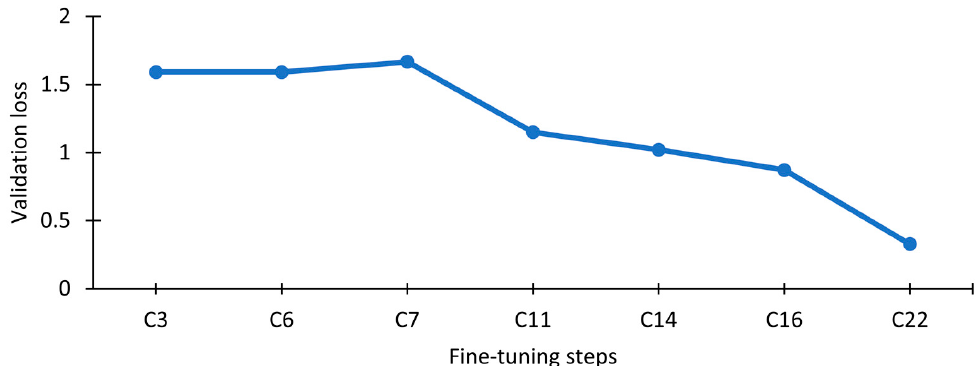
Figure 8. CNN model configuration.